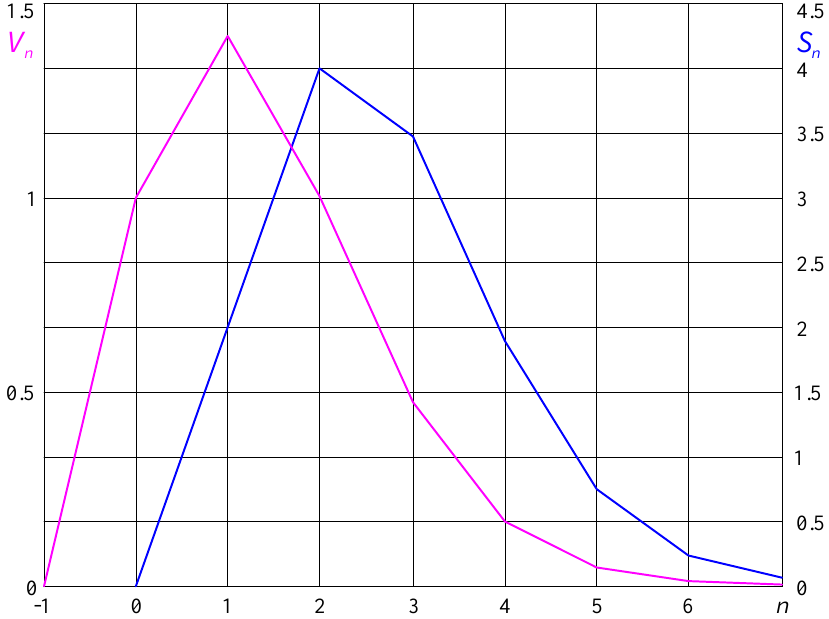
Figure 6. Graphs of volumes ( V ) and surface areas ( S ) of n -orthoplices of unit edge length for n = −1, …,7.